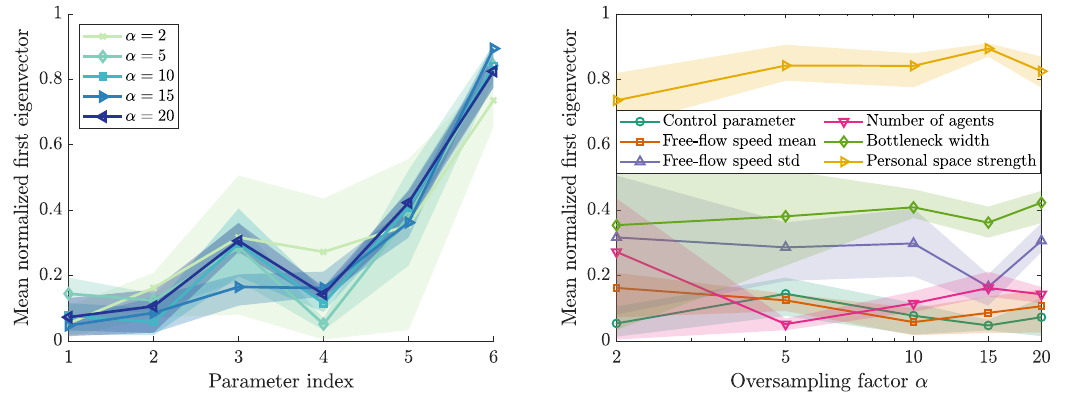
Figure 9. Normalized first eigenvector metric for the bottleneck scenario. The mean eigenvector entries obtained from three runs (solid lines) are shown together with the extrema of the scores (patches). The parameter index is mapped as follows: 1—control parameter, 2—free-flow speed mean, 3—free-flow speed standard deviation, 4 —number of agents, 5—bottleneck width, 6—personal space